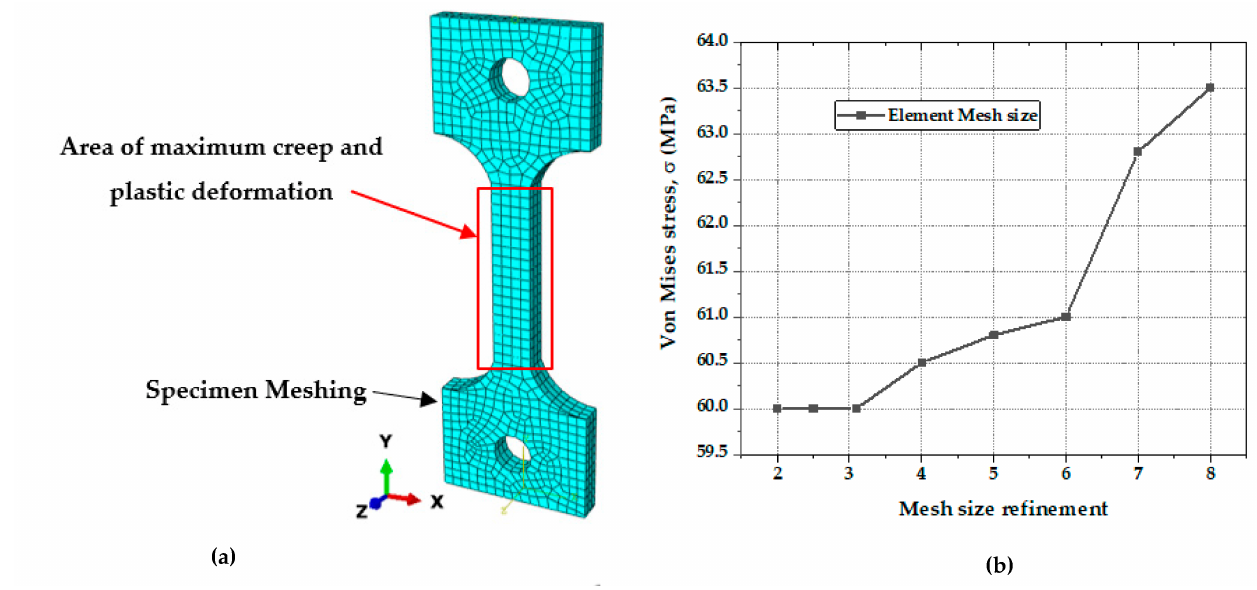
Figure 4. ( a ) Meshing of FE dog-bone model. ( b ) Mesh convergence plot.